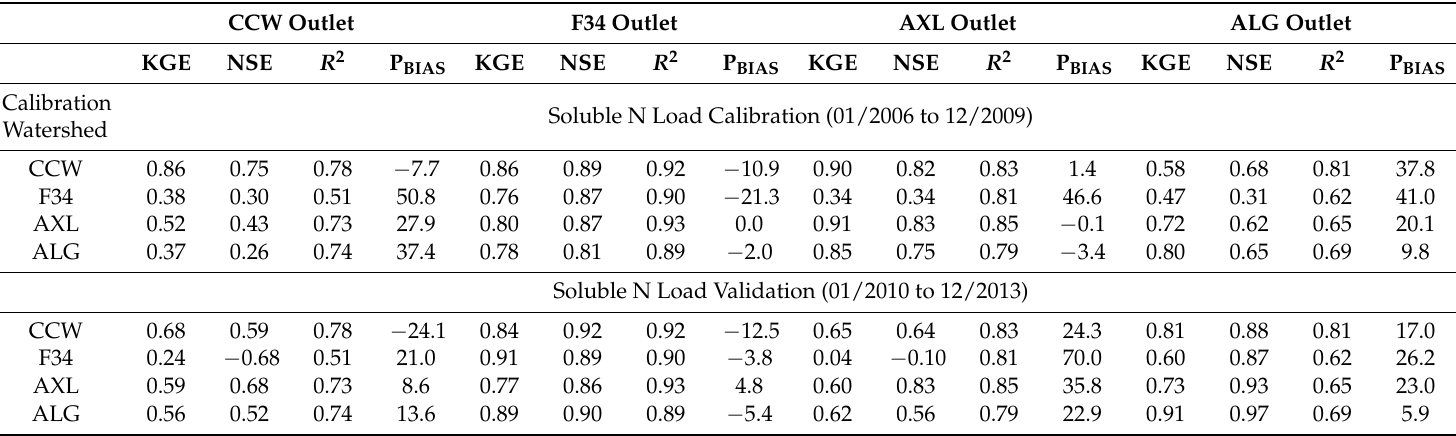
Table 9. Soluble N load calibration and validation statistical metrics for CCW, F34, AXL, and ALG SWAT model